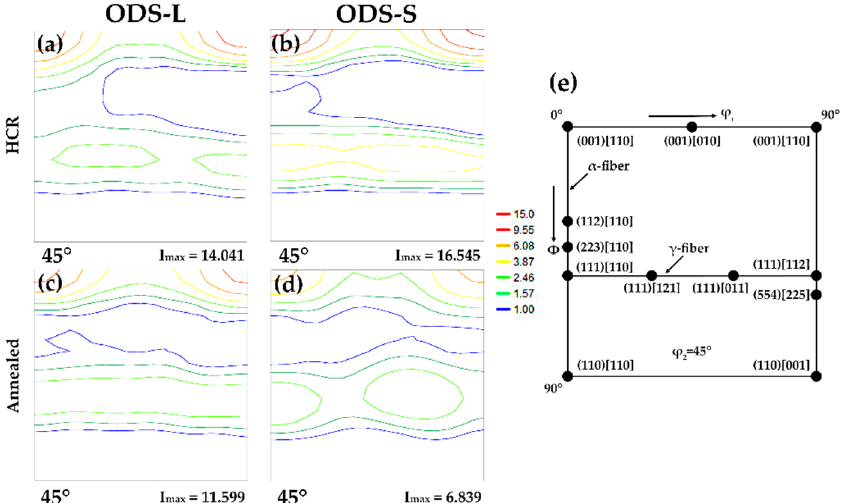
Figure 9. ODF maps obtained on the TS plane after HCR and after annealing at 1273 K. ( a ) ODS-L and ( b ) ODS-S steels after HCR; ( c ) ODS-L and ( d ) ODS-S steels after annealing; ( e ) Euler space section φ 2 = 45° and main fibers of laminate bcc materials.